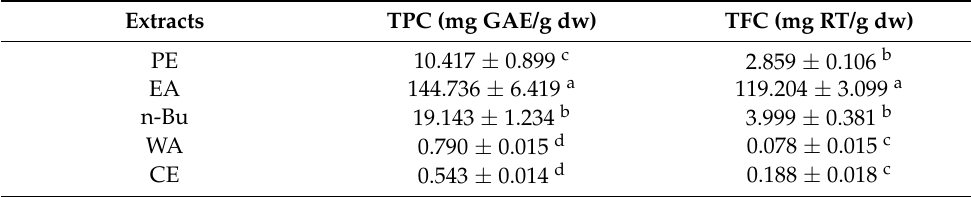
Table 1. Total phenolic and total flavonoid contents of P. sibiricum .